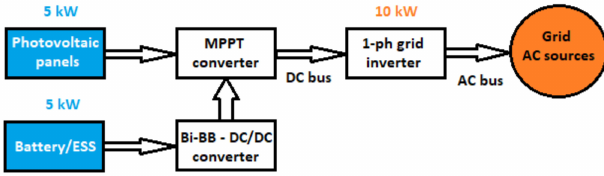
Figure 22. Representation of the operational Scenario 2.